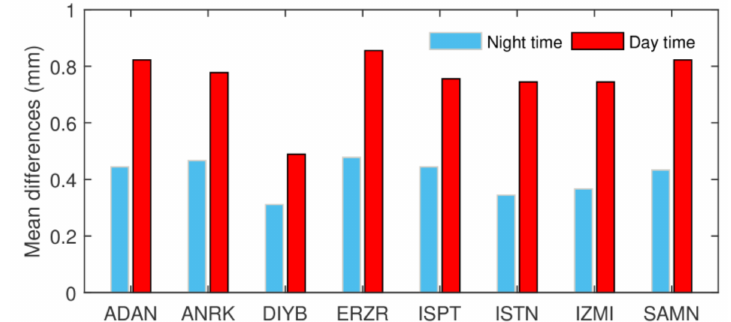
Figure 5. Daytime and nighttime mean ZTD di ff erences on days 167–180 in 2011.